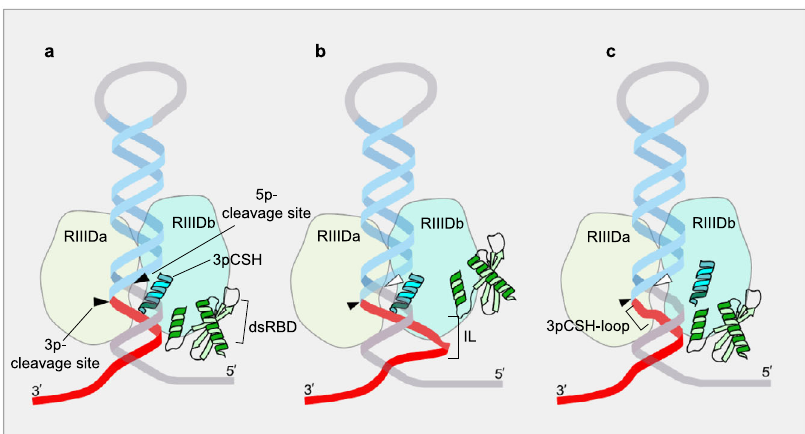
Fig. 7 The conserved single cleavage mechanism of animal DROSHA enzymes. a – c The 3p-strand cleavage of DROSHA RIIIDa is strengthened by two interactions ( a ), RIIIDb_3pCSH-RNA and dsRBD-RNA. The IL ( b ) and 3pCSH-loop ( c ) interrupt the two interactions above, resulting in the single cleavage by